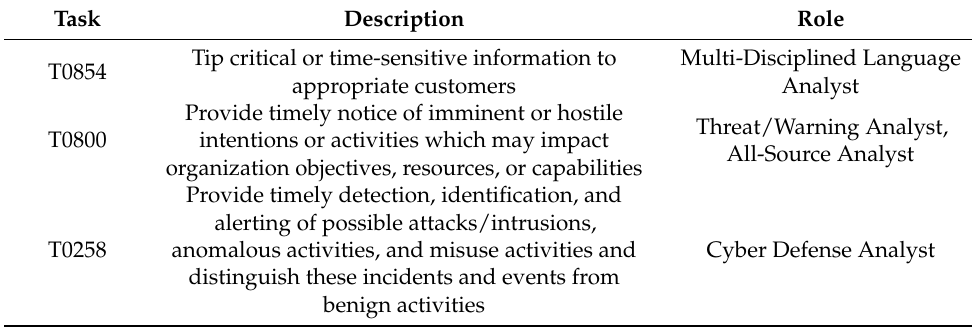
Table 1. Examples of tasks with some emphasis on stressful conditions due to time limits. Task Description Tip critical or time-sensitive information to T0854 appropriate